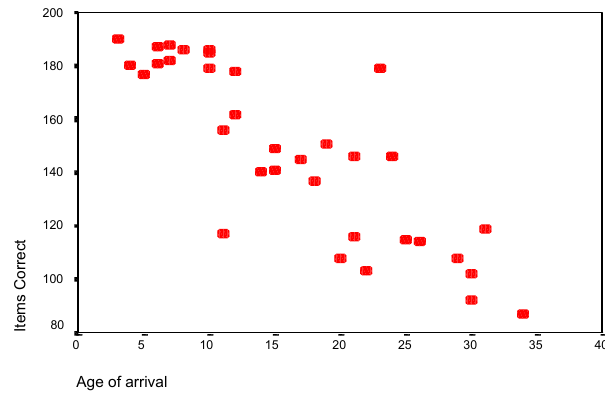
Scatterplots of Participants’ Scores on the GJT